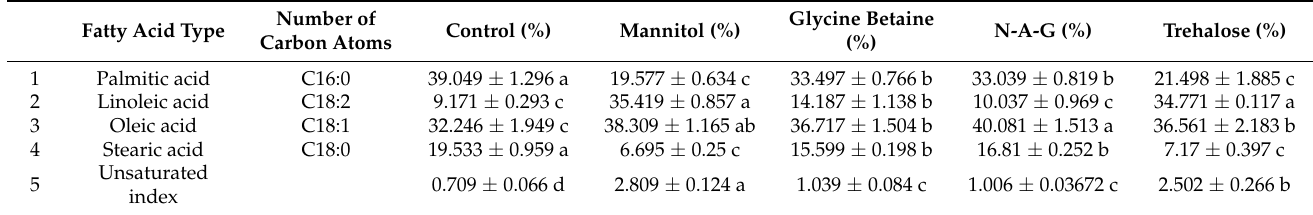
Figure 6. Differences in the expression of genes related to lipid metabolism caused by different exogenous regulators: ( A ) TGL2 gene and ( B ) OLE1 gene. The data are from three independent repeated experiments. The different letters above the bars indicate a significant difference in the expression level of the TGL2 gene and the OLE1 gene for each treatment, according to the least significant difference test ( p < 0.05). Table 2. Analysis of the fatty acid composition and content in chlamydospores in response to different regulators. The values indicate the mean ± standard error (SE). The data are from three independent experiments. The different letters after the values in each row represent significant differences in the content of fatty acids in the chlamydospores produced by adding different exogenous